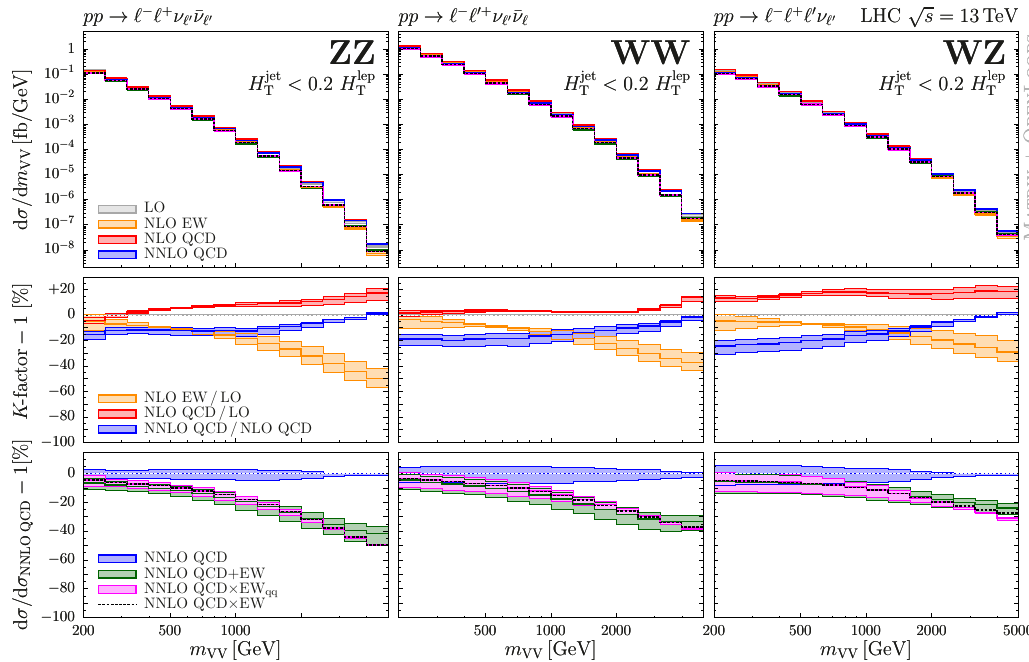
Figure 12 . Distribution in the invariant mass of the reconstructed vector-boson pair for the processes (3.1){(3.3) at 13 TeV. Plot format and predictions as in (cid:12)gure 7, but in addition to the baseline cuts also the jet veto (3.16) is